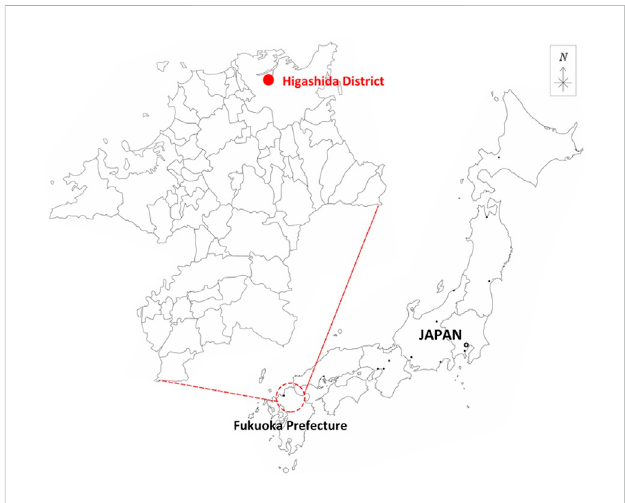
FIGURE 4 Location of Higashida smart community in